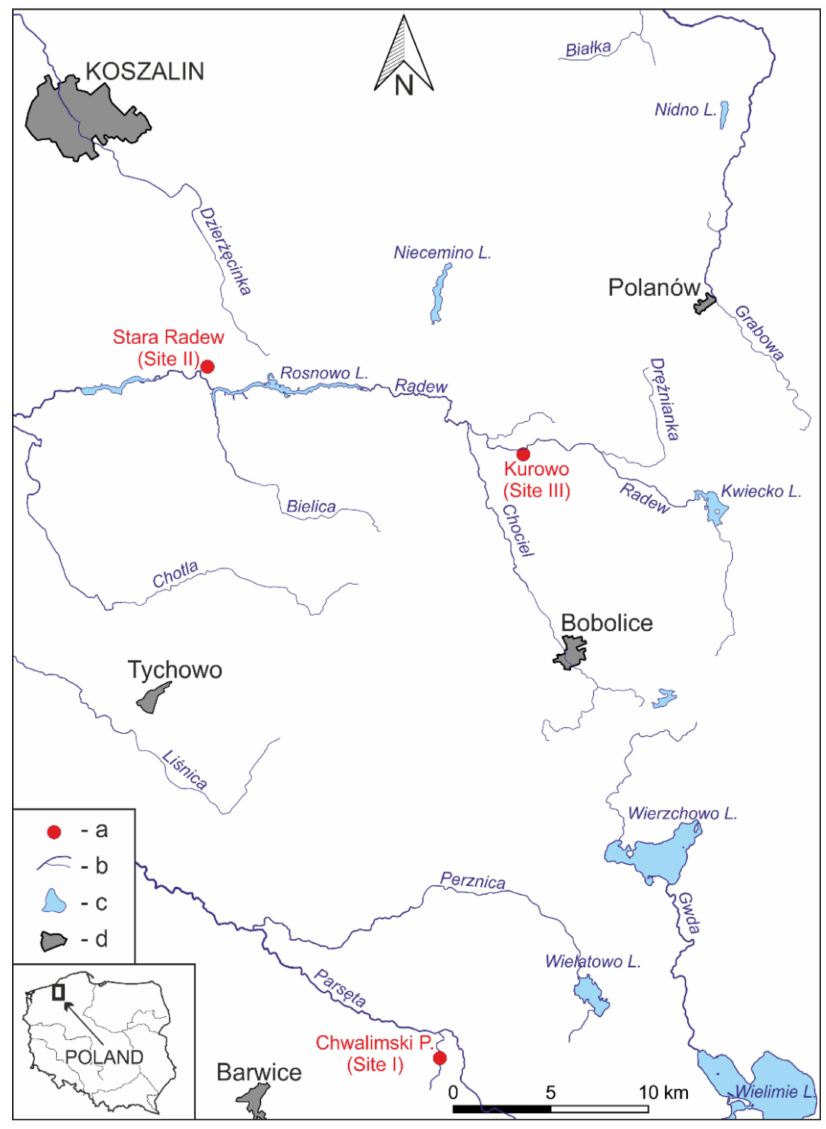
Figure 1. Location of sampling sites. Legend: a—sampling sites; b—rivers, c—lakes, d—urban areas. Table 2. Biometric data of opposite-leaved